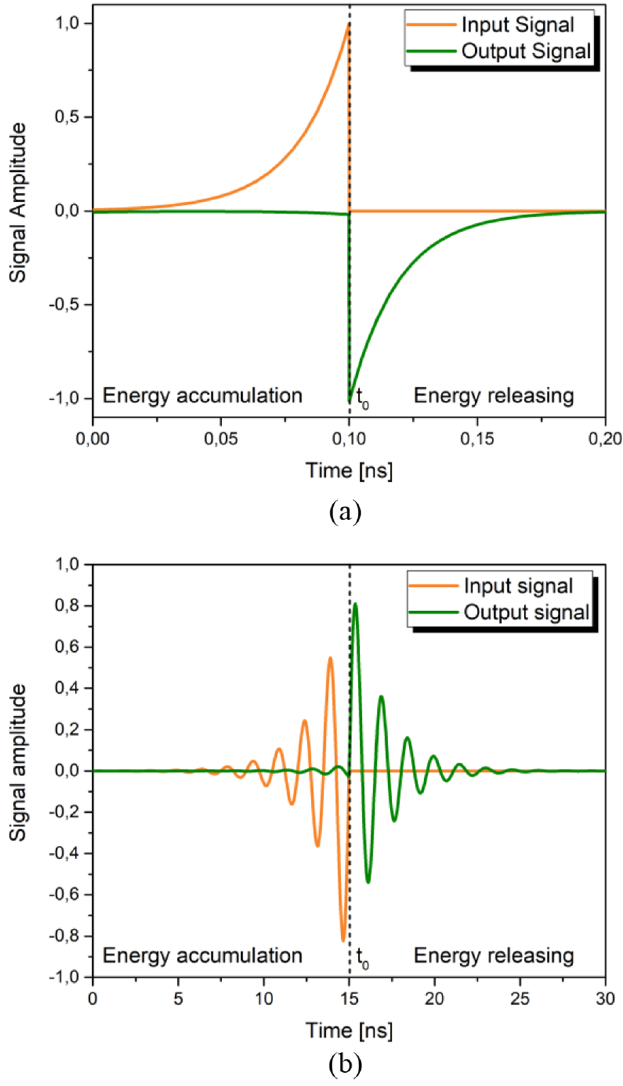
Fig. 4. Amplitude of the incident and released signals of the reactive load for parallel connection of L mts = 23 nH and (a) L cav = 11 nH and (b) C cav = 2.45